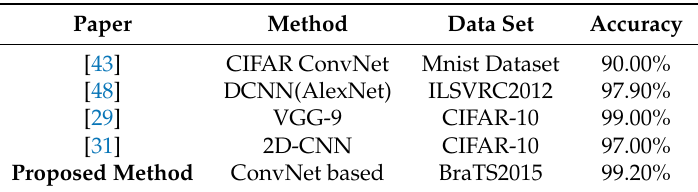
Figure 7. Accuracy rate and error rate comparison of all optimizers using our proposed architecture: ( a ) accuracy rate and ( b ) error rate. Table 11. Comparison of accuracy values with state-of-the-art